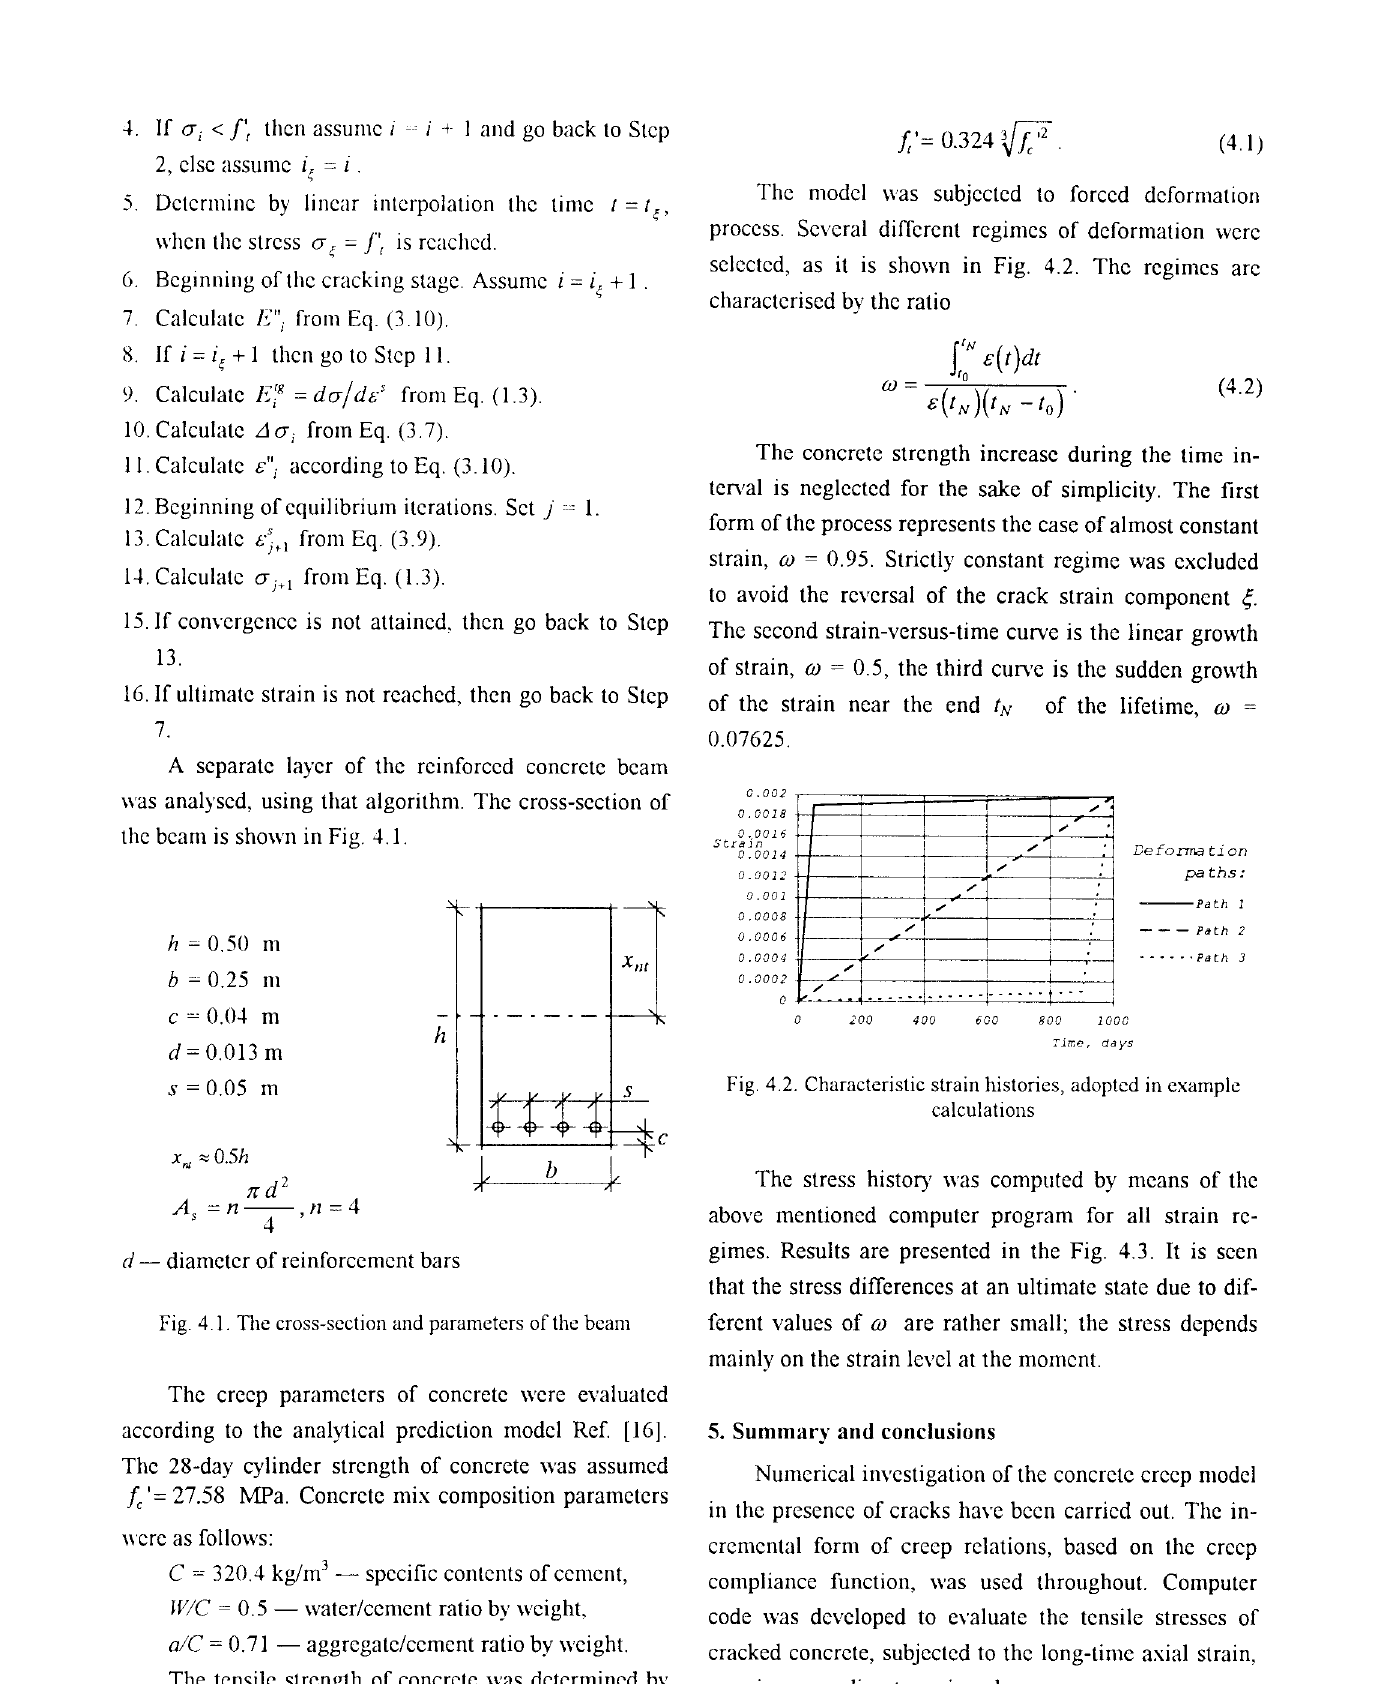
Fig. 4.1. The cross-section and parameters of the beam The creep parameters of concrete were evaluated according to the analytical prediction model Ref. [ 16 j.